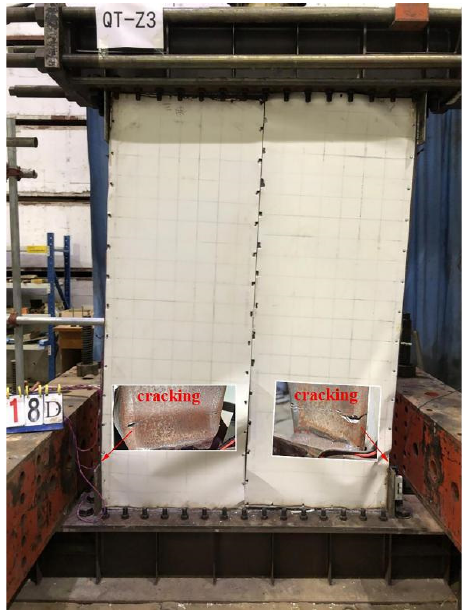
Figure 13. Failure image of QT − Z9. When the displacement of QT − Z9 reached 10 mm, a slight bulge and fold were observed at the bottom left corner of the left wall panel. During the third stage, the middle part of the wall panel bulged and the sound continued. When the displacement reached 40 mm, the thin steel plates were torn near the screws. In the ninth stage, the back wall panel buckled and the folds increased. Most of the screws were indented, and most of the edge of the wall panel slipped. In 16th stage, when the displacement reached 85 mm, large cracks appeared at the bottom of the middle column, as shown in Figure 13, and loading stopped. The damage mode was the same as QT − Z3. 4. Test Results